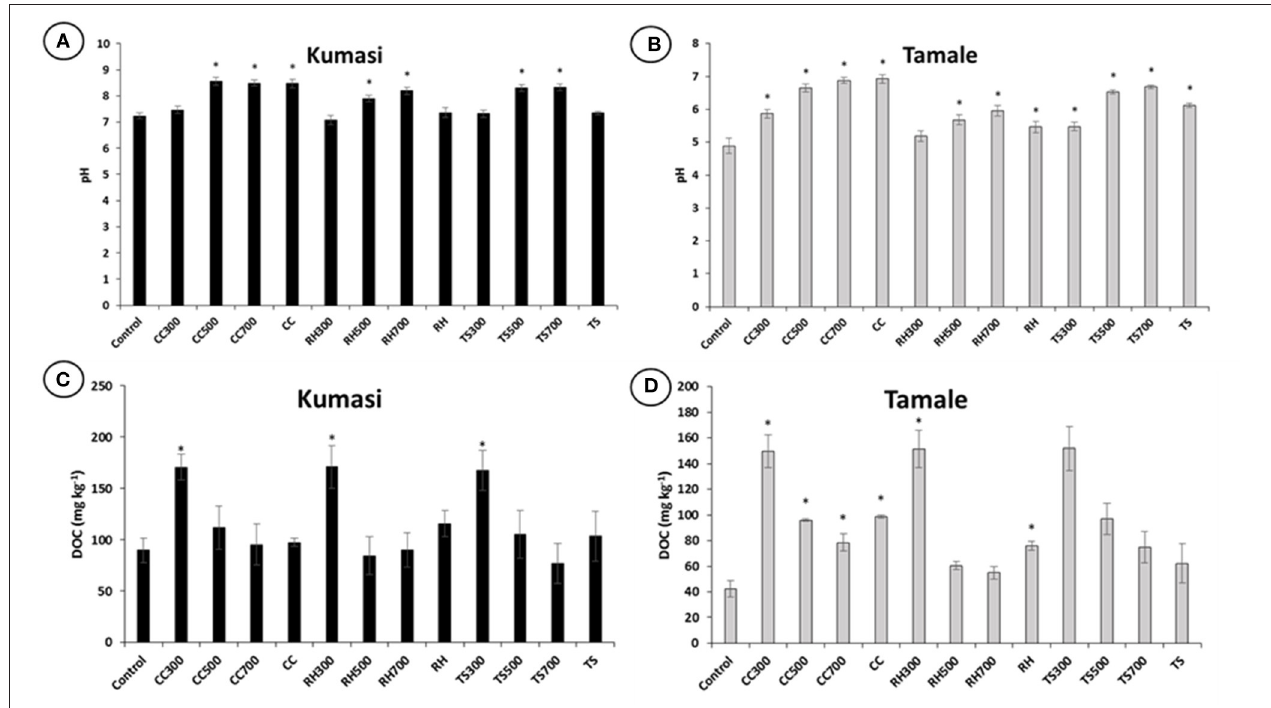
FIGURE 1 | Biochar influence on soil pH and DOC in water extracts in Kumasi (A,C) and Tamale (B,D) soil. The control treatment comprised no amendment. CC, RH and TS represent treatments amended with 5% (w/w) corn cob biochar, rice husk biochar, and teak sawdust biochar, respectively, made in the laboratory at 300, 500, or 700 ◦ C, or made in the field using an ELSA barrel (CC) or a Japanese retort stove (RH and TS). Data with asterisks are statistically significantly different from control ( p < 0.05). Error bars represent standard deviation ( n =